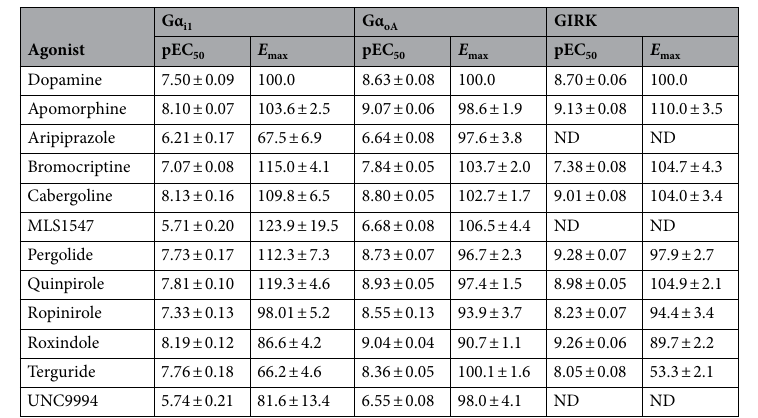
Table 3. Potency (pEC 50 ) and maximal effect (E max ) estimates for agonists activating D 2 R G protein signalling pathways. Concentration–response curves from Fig. 5 were analyzed using a three-parameter fit (Eq. 1). Values represent the mean ± SEM. ND Not determined: unable to be determined due to insufficient response to allow accurate fitting of the